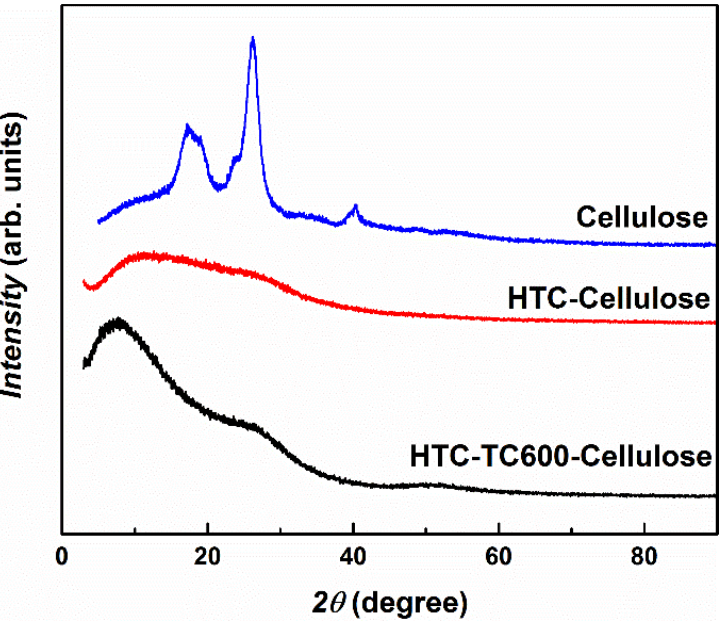
Figure 2. XRD patterns of the prepared particles: cellulose, HTC-Cellulose and HTC-TC600-Cellulose. Fourier transform infrared spectroscopy and Raman spectroscopy were used to ana- lyze the chemical composition changes in the carbonized cellulose when compared to pure cellulose. For pure cellulose particles, a typical spectrum representing cellulose was ob- served. Namely, the broad spectral band at 3334 cm − 1 and the spectral band at 2896 cm − 1 represent hydroxyl group and C–H stretching, respectively, while a dominant band at 1029 cm − 1 stands for the etheric C–O group present in the ring (Figure 3a) [3]. After the hydrothermal carbonization process (Figure 3a), the intensity of the cellulose wide stretch- ing band attributing to the vibrations of the hydroxyl group at 3320 cm − 1 decrease, and during the thermal carbonization the peak disappears completely. Furthermore, during hydrothermal carbonization, benzene units are possibly created which is reflected by